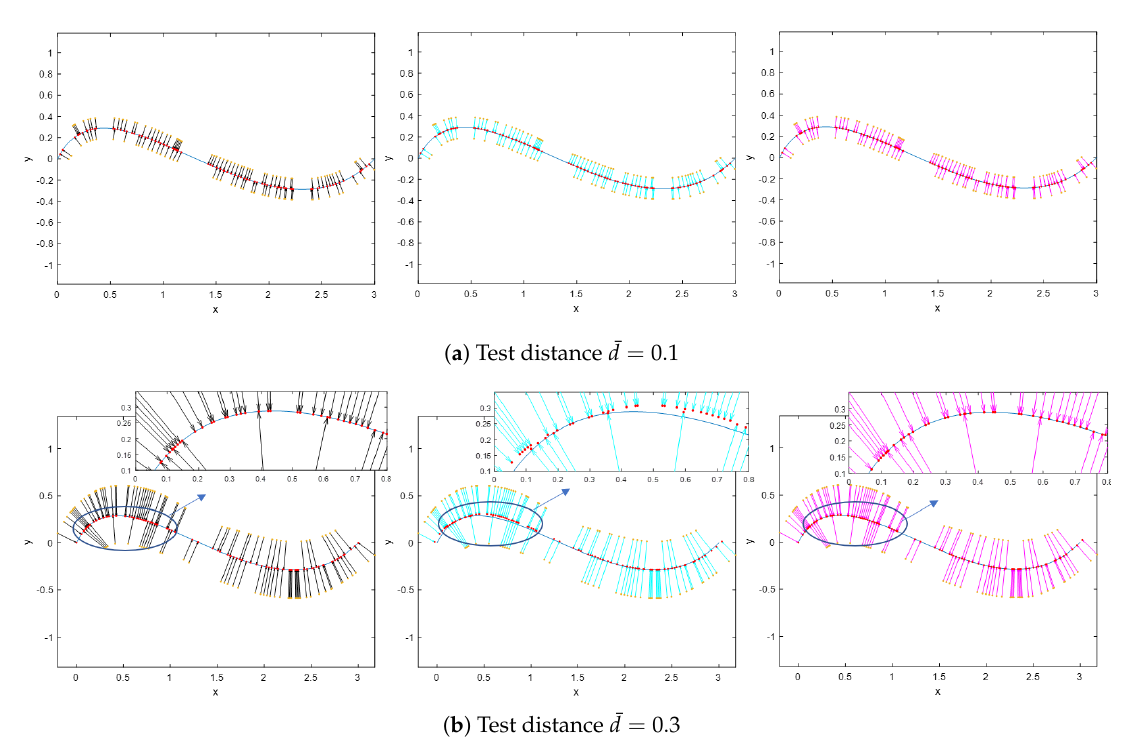
Figure 9. Point projection for cubic Bézier curve in two-dimensional physical space using the developed algebraic method as well as Newton–Raphson iterations for: ( a ) test distance ¯ d = 0.1; and ( b ) test distance ¯ d = 0.3. From left to right, Newton–Raphson method, first-order algebraic point projection, and second-order algebraic point projection are shown. The inset image shows that first-order point projection fails to converge onto footpoints on the curve when distances are